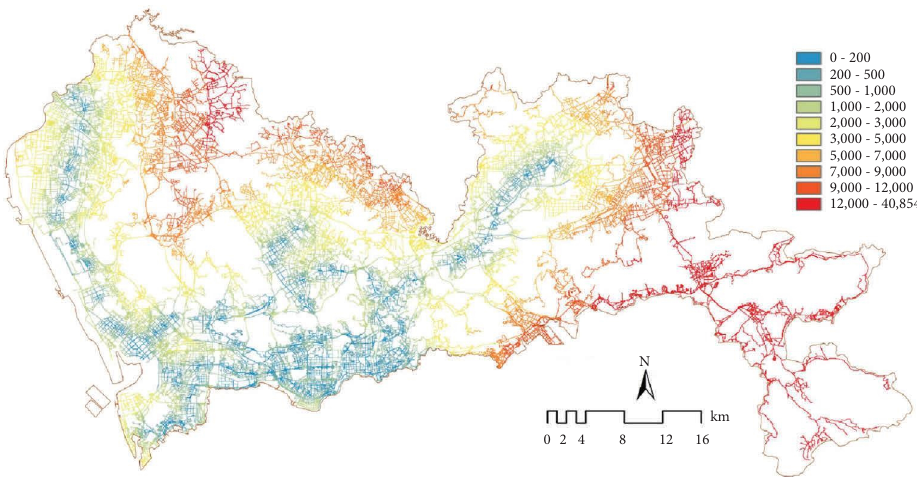
Figure 2: Distance from metro station.